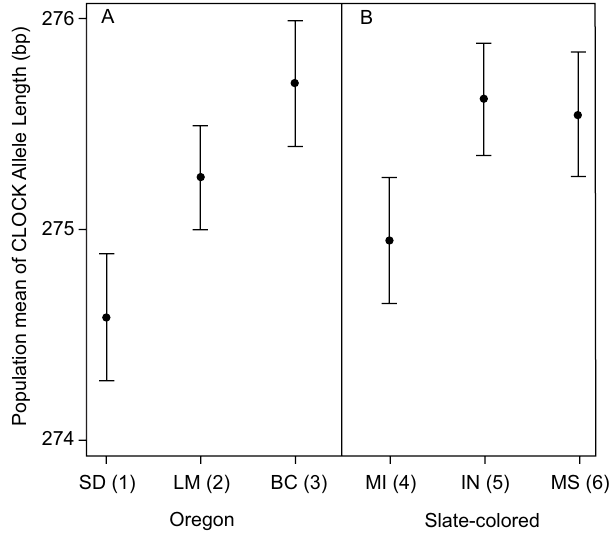
Figure 4. CLOCK allele length within sub-species groups. Within each subspecies group for which we have multiple sampling locations, there is a trend for populations that migrate a longer distance to have longer CLOCK alleles. Figure shows mean and standard error for Oregon juncos listed by breeding grounds (panel A; ANOVA, p = 0.056) and slate-colored juncos listed by wintering grounds (panel B; ANOVA, p = 0.18; see text for details). Population migration scores are shown in parentheses with higher numbers indicating populations that migrate longer distances (see Table 1 for more